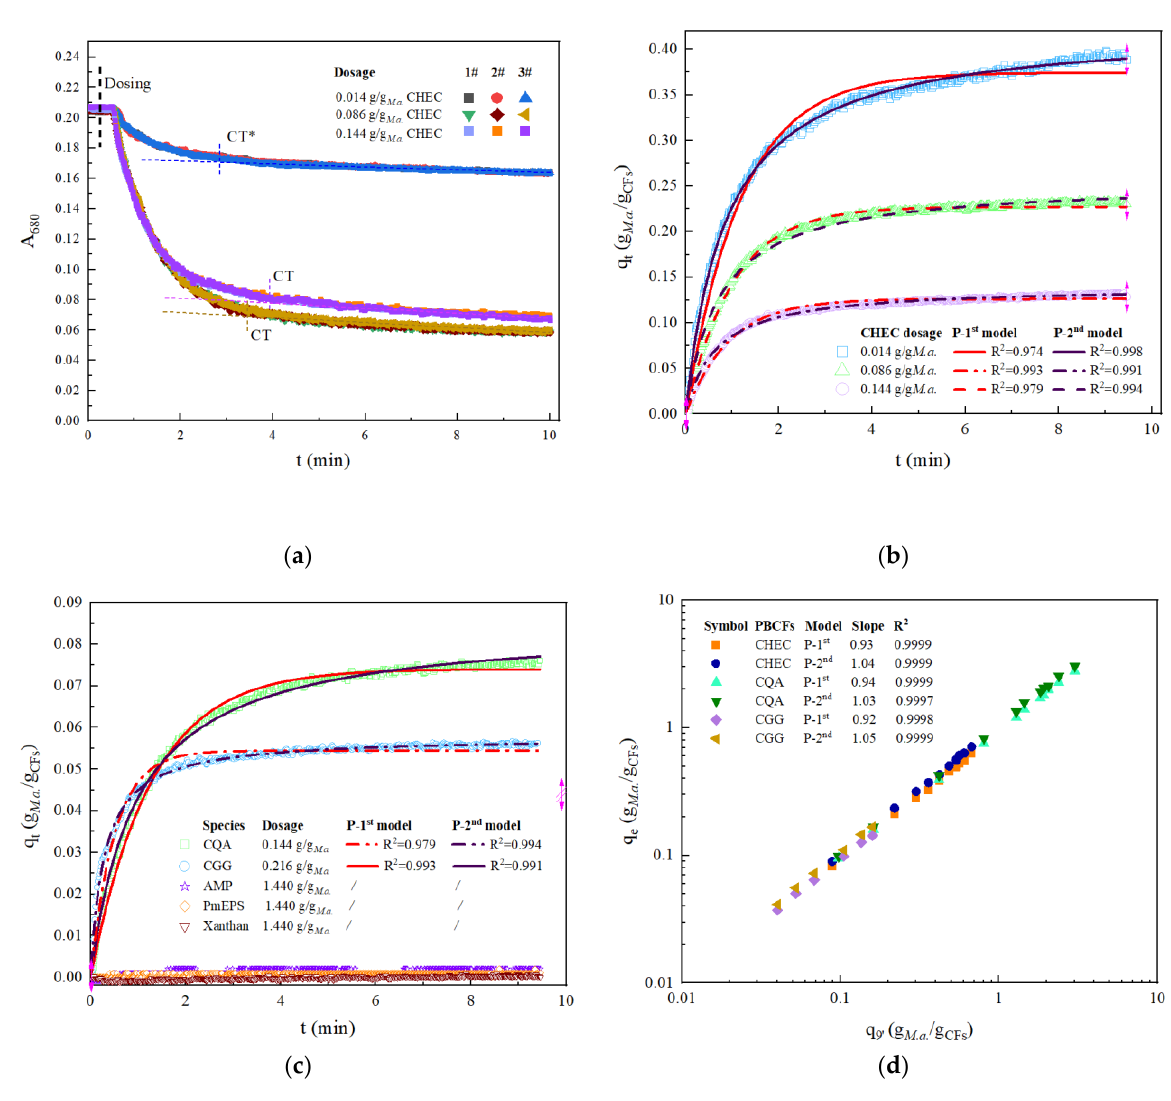
Figure 2. TR kinetic profiles of M. aeruginosa coagulation by cationic polysaccharides: ( a ) Triplicated TR variation in A 680 for CHEC; ( b ) TR coagulation by CHEC fitted with models; ( c ) TR coagulation curves for other PBCFs; ( d ) Linear correlation of q 9′ and q e.